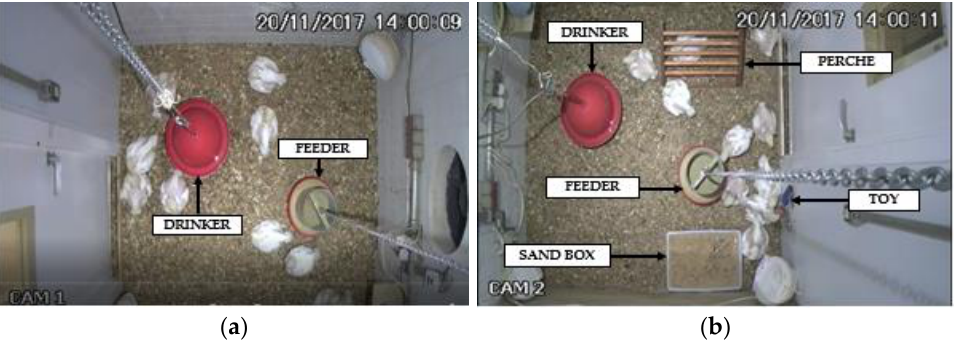
Figure 3. Top view of the unenriched ( a ) and enriched ( b ) compartment through the cameras installed on the ceiling of each compartment of the climate chamber.